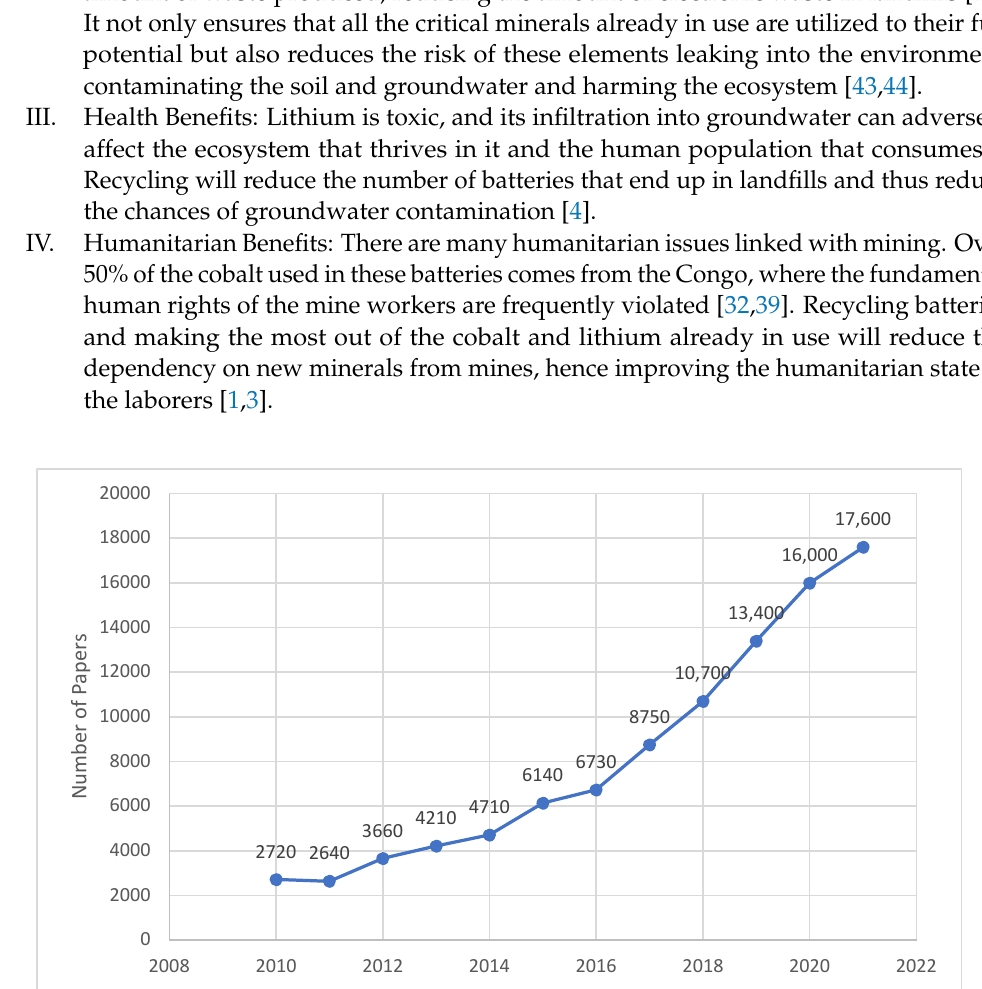
Figure 4. Lithium-ion battery recycling process. 4.3.1. Sorting, Discharge, and Disassembly Initially, preprocessing is performed, where the chemical composition of the battery is not altered. This phase involves disassembly, stabilization, and sorting according to the chemical composition, battery type, density, shape, and size. After the preprocessing phase, the batteries are refined and concentrated using one of the three methods discussed in the next sections [1,46].